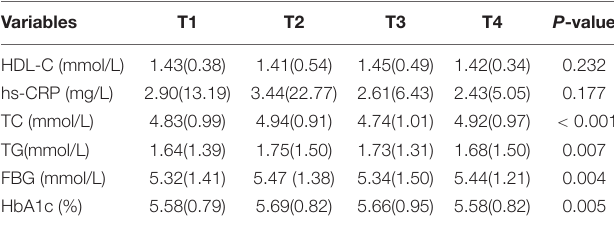
TABLE 3 | Difference for hyperuricemia (HU)-related factors across dietary branched-chain amino acids (BCAA) consumption trajectories in